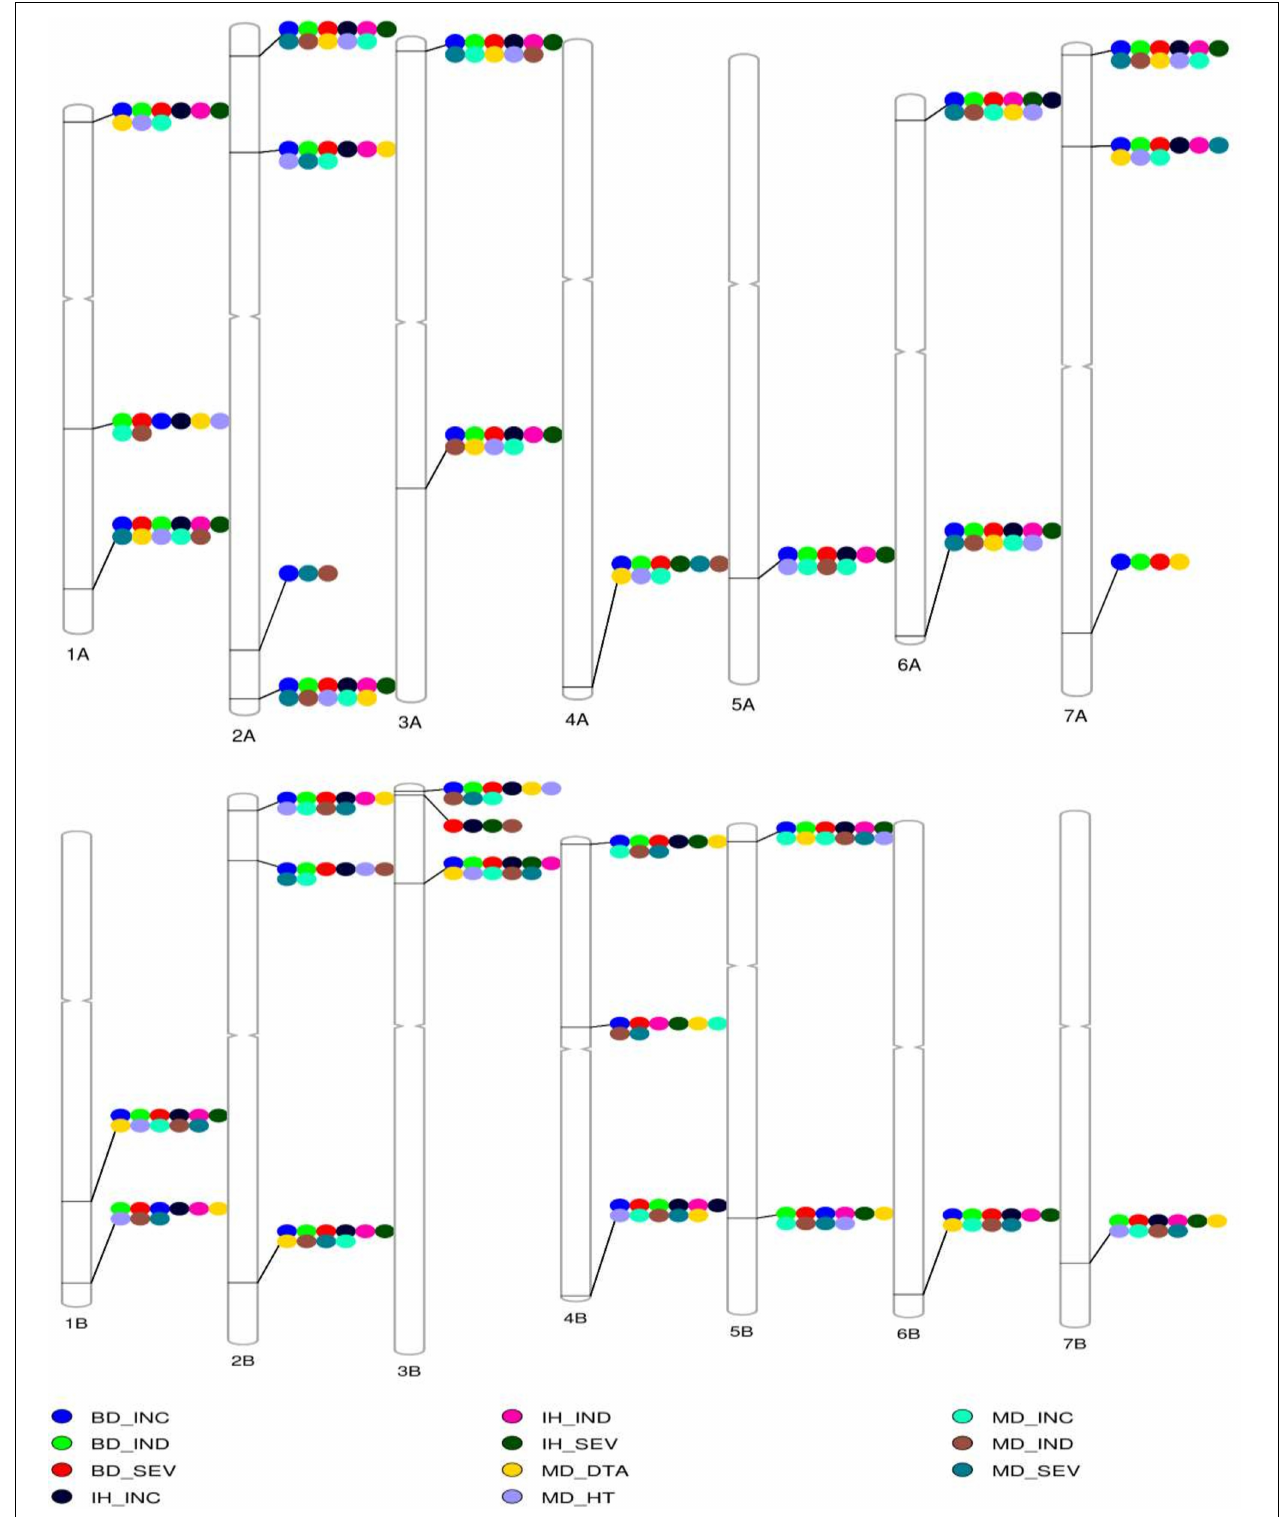
FIGURE 5 | The reference genotype–phenotype map. A reference genotype–phenotype map with the most significant trait-associated markers in each chromosome aligned to the reference sequence of common wheat (International Wheat Genome Sequencing Consortium [IWGSC], 2018). MB, Morden, MB; BD, Brandon, MB; IH, Indian Head, SK. FHB incidence (INC), severity (SEV), index (IND), plant height (HT), and days to anthesis (DTA).